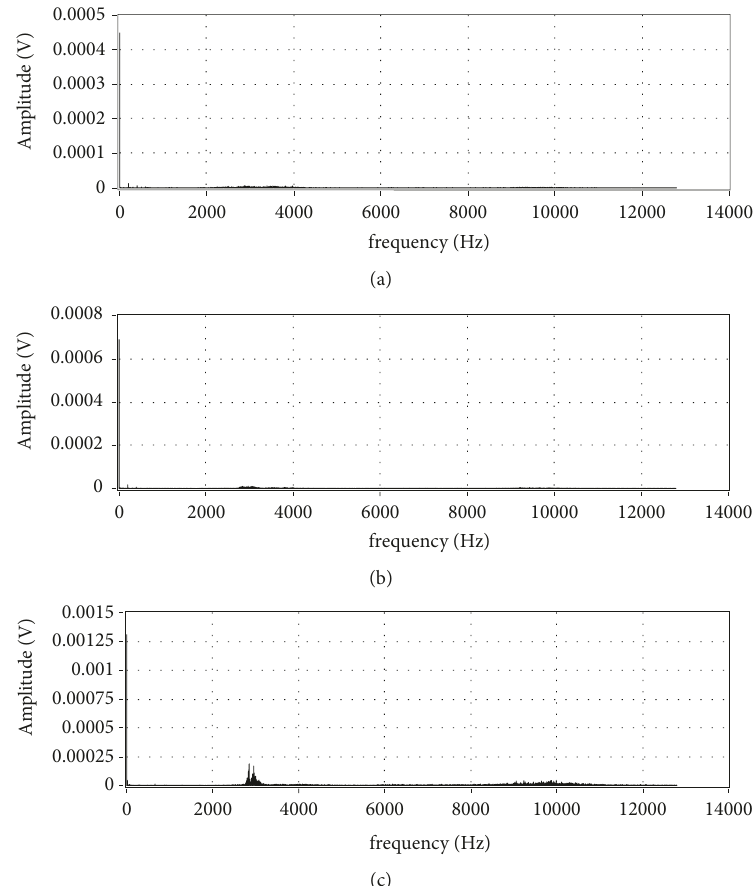
Figure 9: Frequency domain waveforms of the vibration signal (amplified 100 times): (a) initial tool wear; (b) normal tool wear; (c) severe tool wear (cutting speed 64.6m/min; feed speed 0.11mm/r; depth of cut 1.2mm).